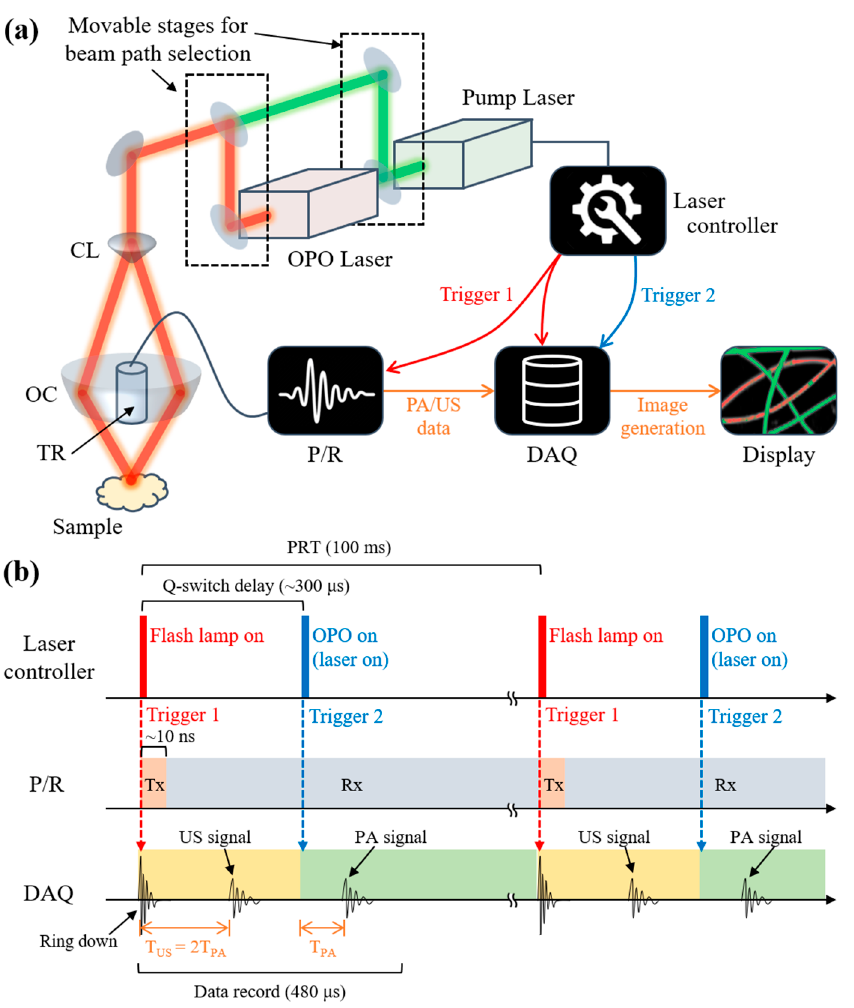
Figure 1. Schematic illustration of the dual-modal PA and US imaging system. ( a ) Configuration of the system. ( b ) The operation sequence of the system for simultaneous dual-modal imaging. PA, photoacoustic; US, ultrasound; TR, transducer; OC, optical condenser; CL, conical lens; OPO, optical parametric oscillator; P/R, pulser-receiver; DAQ, data acquisition module; PRT, pulse repetition time; Tx, transmission; Rx, reception; T US , flight time of ultrasound signal; T PA , flight time of the photoacoustic signal.